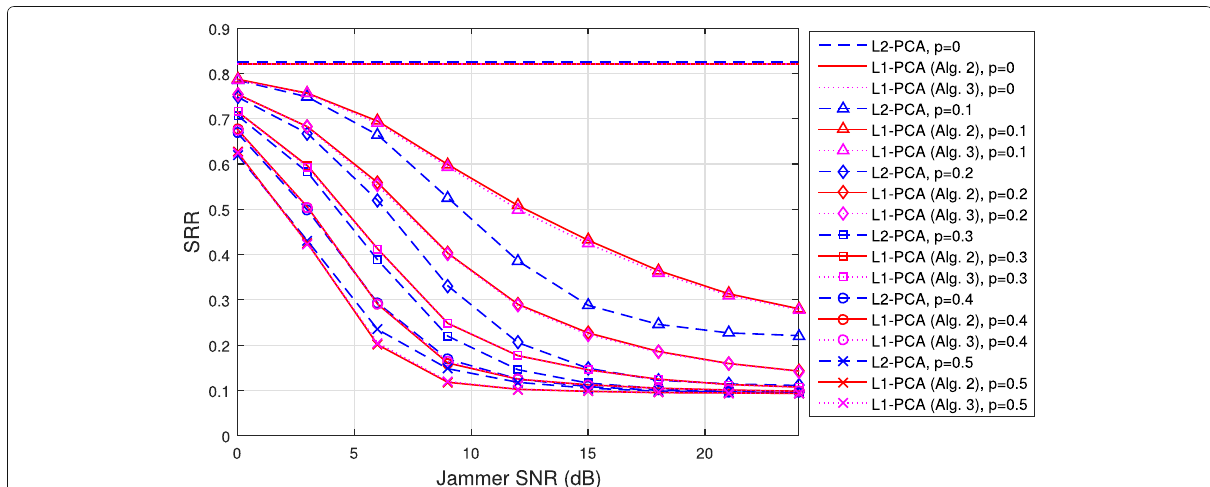
Fig. 7 Average SRR vs. jammer SNR, for: L2-PCA (MUSIC), optimal L1-PCA, calculated by means of Algorithm 2 in Fig. 3, and L1-PCA by means of Algorithm 3 in Fig. 4. For each estimator, we present the RMSE curves for p = 0,.1,.2,.3,.4,.5. N = 8, D = 3, θ = − 41 ◦ , θ (cid:13) = 24 ◦ , source SNR 2 dB